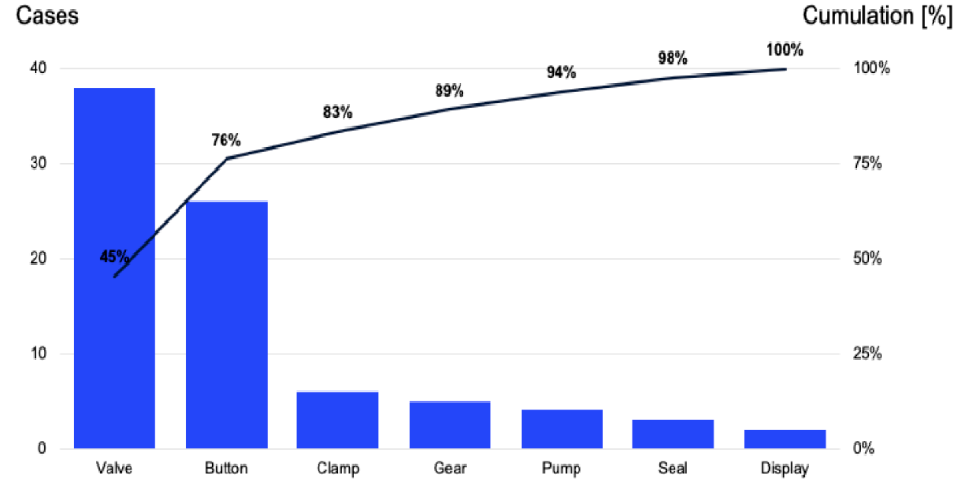
Figure 2. Example of a Pareto diagram, [34].